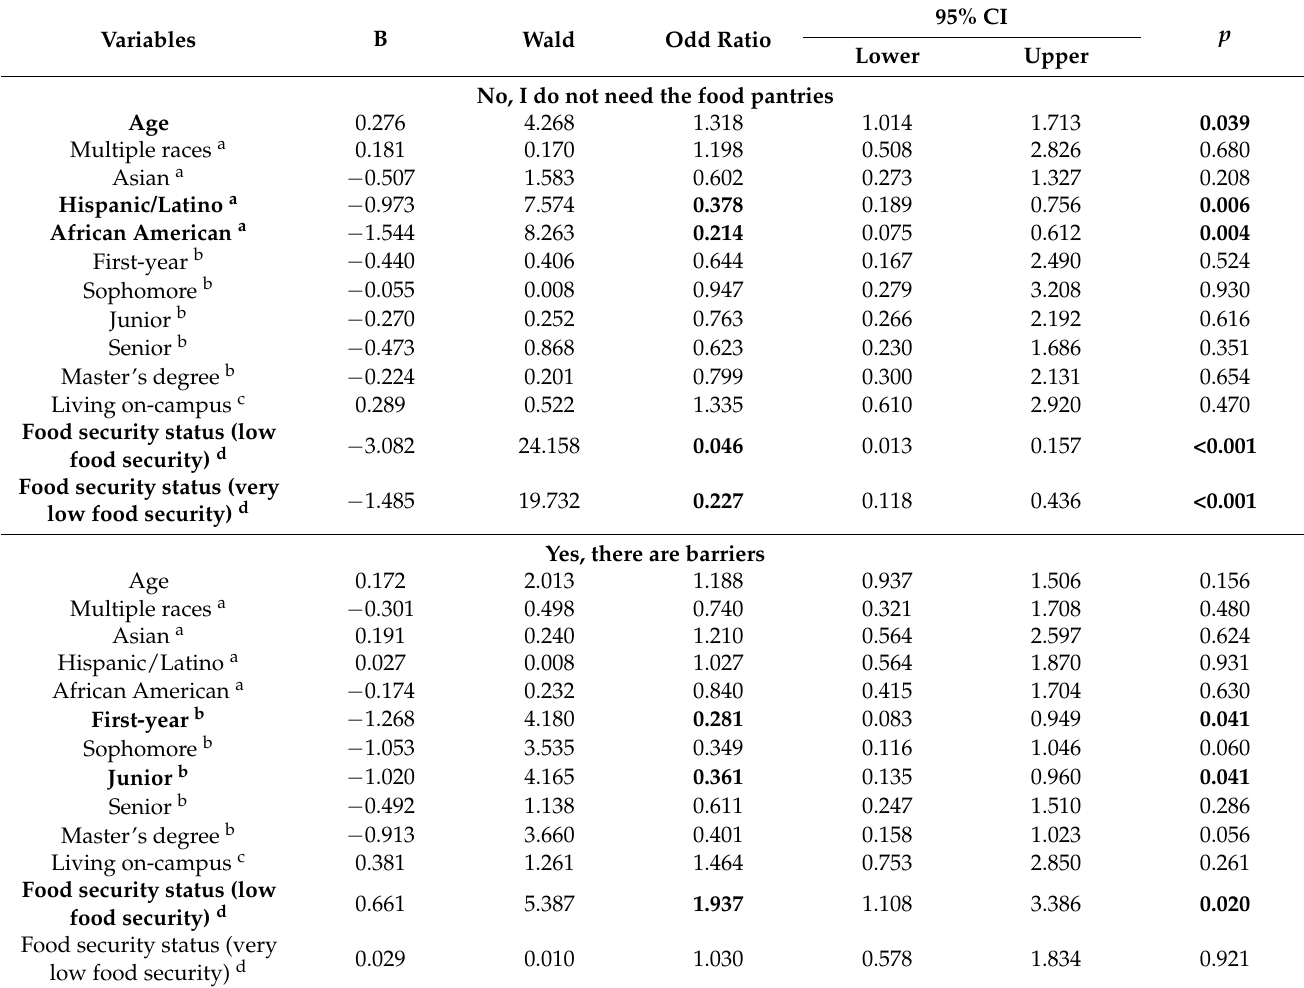
Table 6. Summary of Logistic Regression Predicting Food Pantry Barriers by Demographic Factors and Food Security Status.